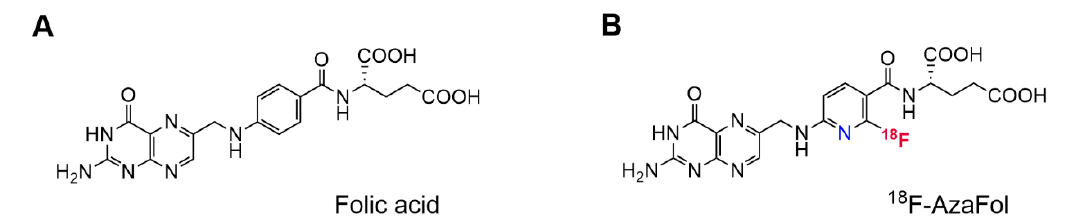
Figure 2. ( A ) Chemical structure of folic acid; ( B ) chemical structure of 18 F-AzaFol.